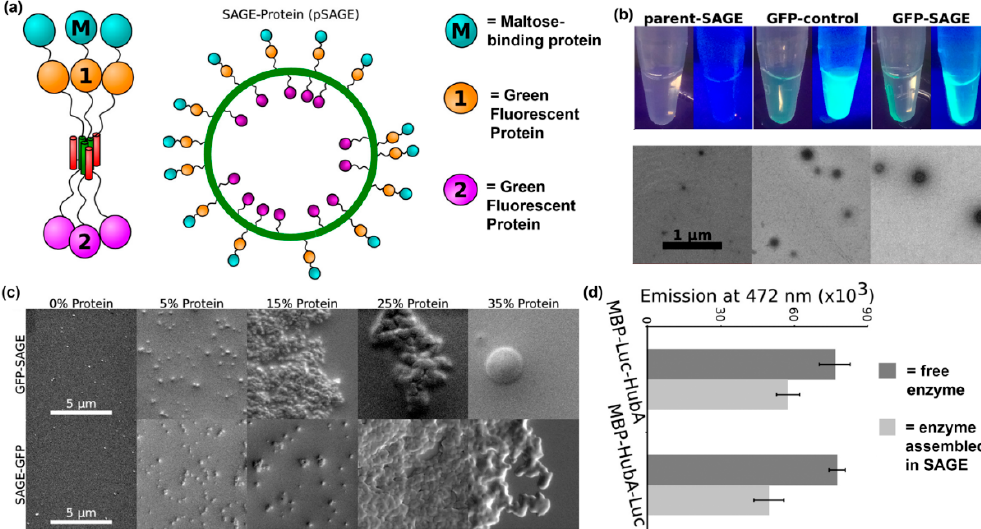
Figure 9. Self-assembled cages displaying protein domains. ( a ) Schematic representation of a cage formed from self-assembling peptide–protein conjugates. Proteins can be displayed within the core or on the surface of the cage using this methodology. ( b ) Representative fluorescence still images and transmission electron microscopy images of assembled peptide–protein cages. Particles assembled in the presence of GFP fusion proteins were fluorescent. Particles with average diameters of ~100 nm and uniform morphologies were observed. ( c ) The average particle diameter depended on protein orientation. Slightly larger particles were obtained when proteins were conjugated on the outside of the particles. ( d ) Representative SEM images of assembled particles incorporating 0%, 5%, 15%, 25%, and 35% (volume ratio) peptide–protein conjugates. Individual particles were observed below 15% protein loading, while aggregation occurred at higher concentrations. ( e ) Bioluminescence emission at 472 nm from 5% Renilla luciferase assembled into cages (light gray) or free in solution (dark gray). Differences between assembled and soluble enzyme were insignificant. Adapted with permission